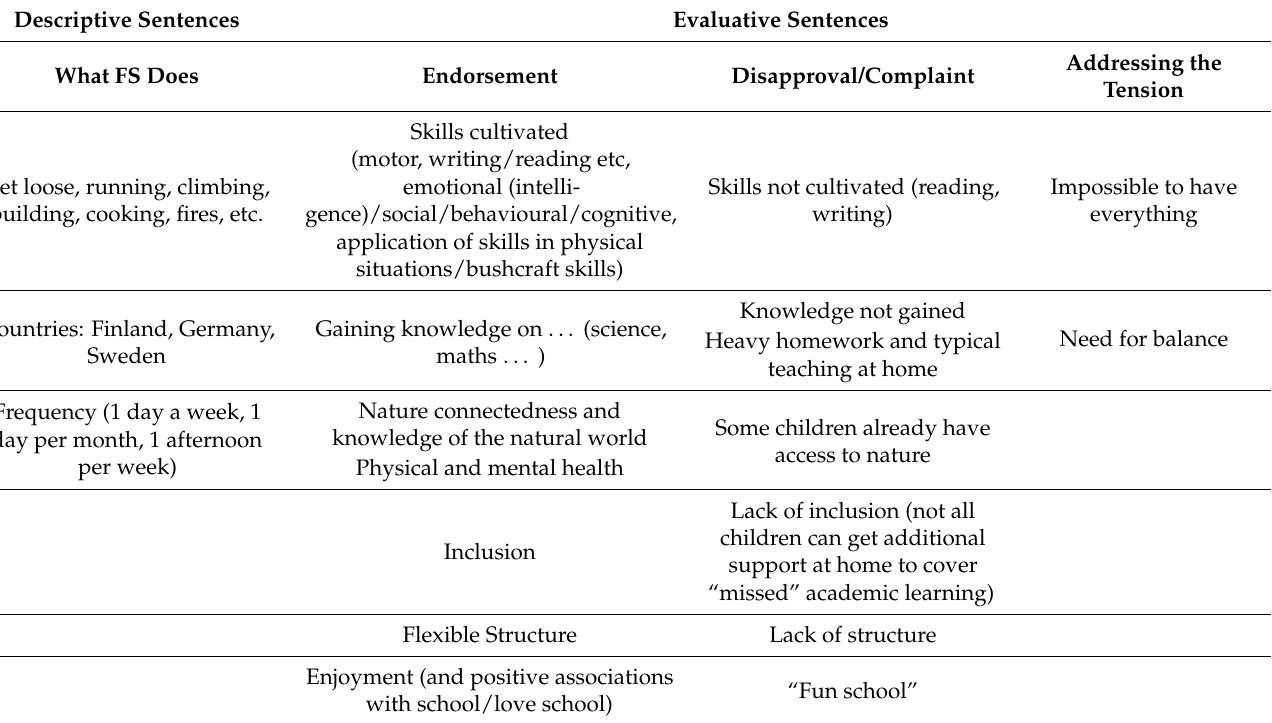
Table 1. Analysis of responses within the “Forest school-Why? AIBU [Am I Being Unreasonable]- probably?”